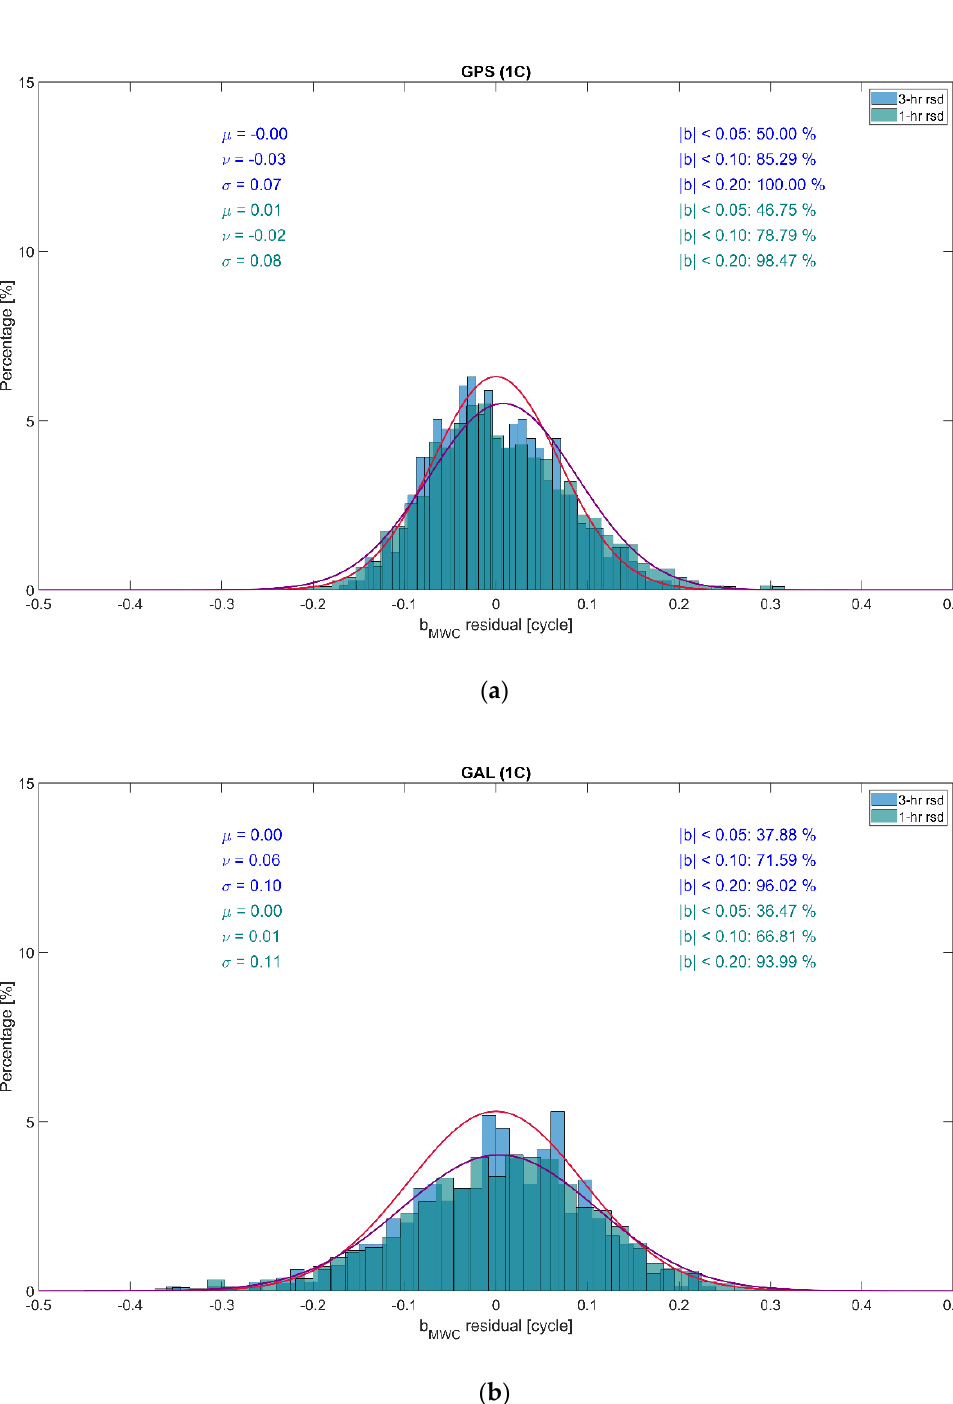
Figure 11. Distributions of the residuals of the sub-daily ϐ MWCs estimates for GPS ( a ) and GALILEO ( b ). Red and purple curves show the approximating normal distributions of 3 − h and 1 − h long sub-daily bias estimates, respectively.